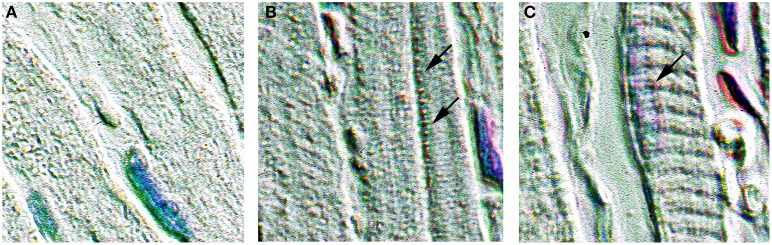
Expression of NTT-MMP-2 in transgenic hearts. Immunohistochemical staining for the eGFP epitope tag present on the NTT-MMP-2 transgene. Pseudo-color enhanced immunohistochemistry of wild type (A) and transgenic (B,C) ventricular sections (400× original magnification). NTT-MMP-2 is present within mitochondria, particularly within subsarcolemmal mitochondria (indicated by arrows in B) and localizes to clusters in register with the Z-line (arrow in C). No NTT-MMP-2 staining pattern was evident in wild type hearts. Intracellular NTT is much less abundant that the FL-MMP-2 isoform, therefore, pseudo-color enhancement was used to improve contrast and to visualize the subcellular localization.